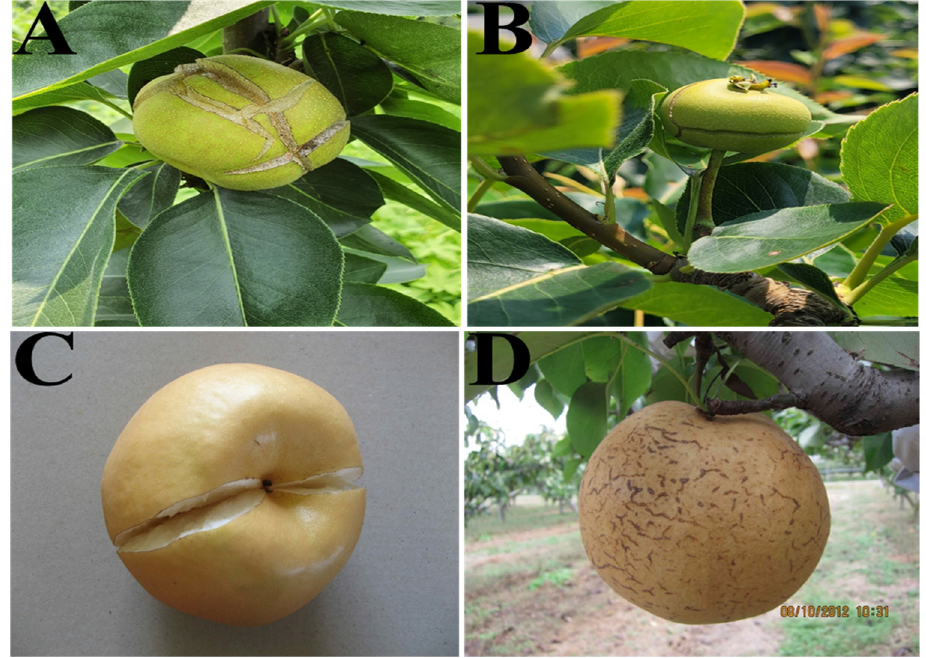
Figure 1. Fruit cracking in pears. ( A , B ) Fruit cracking in the early stage of growth; ( C ) macro-cracks in the mature stage of growth; ( D ) micro-cracks on fruit.